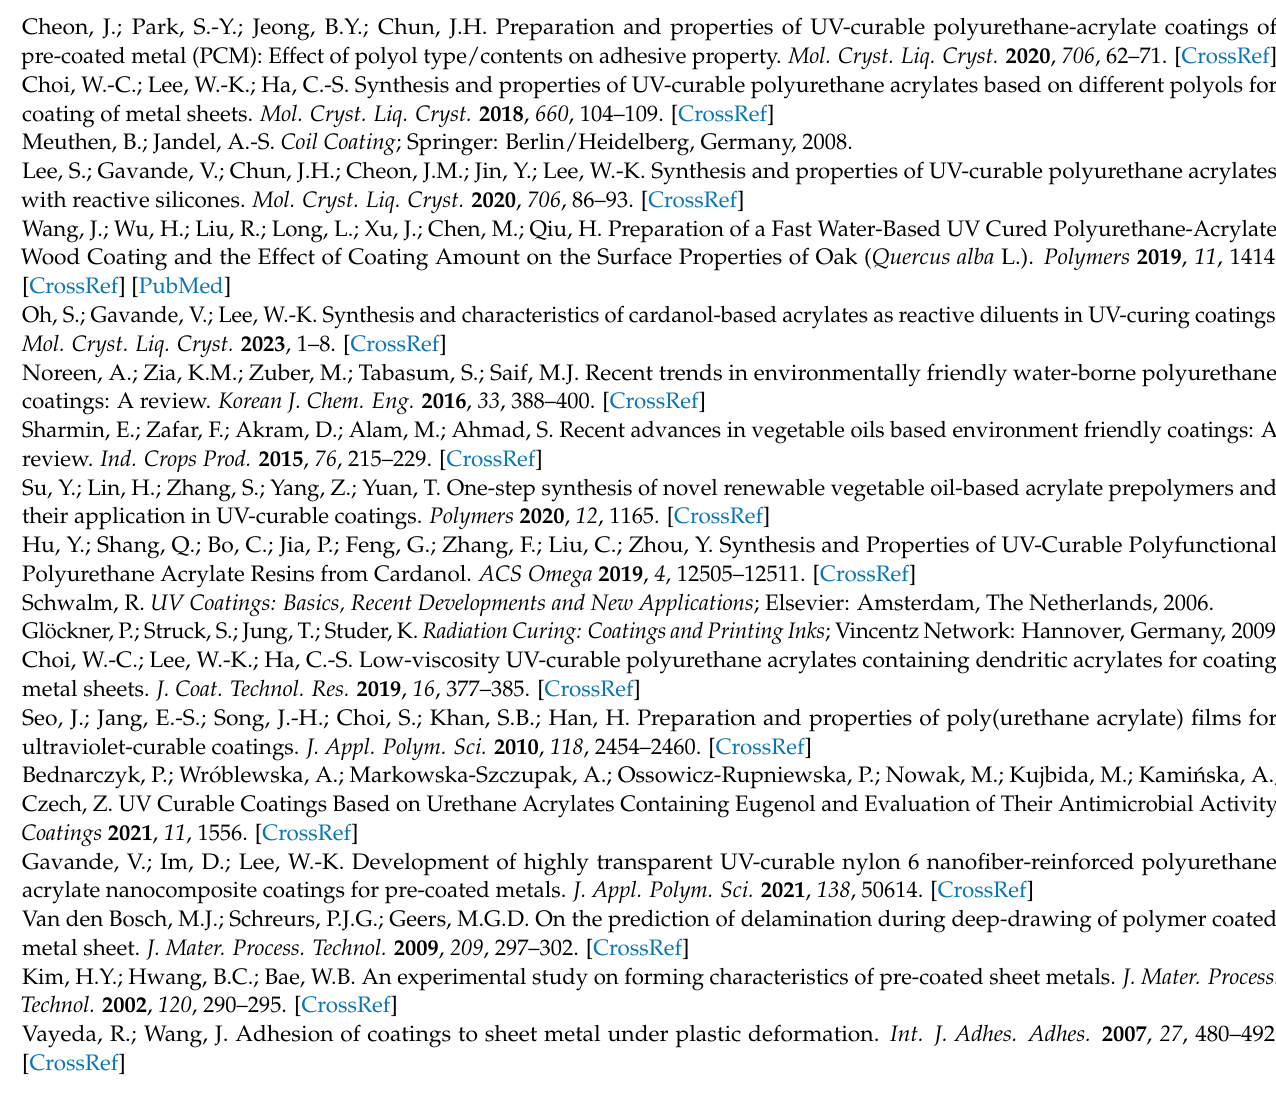
thickness test on UV-cured PUA coating films in the N 2 atmosphere. Figure S9: Formability test: Compression and tension area images of UV-cured PUA coating films in the N 2 atmosphere, and Figure S10: ASAME strain signatures of UV-cured PUA coating films (A) P-IBOA and (B) P-IBOMA in the N 2 atmosphere; Table S1: Viscosities of the UV-curable PUA coatings, Table S2: Gel content (wt%) of the UV-cured PUA coating films, and Table S3: LPH and reduction thickness by Cross-die cup drawing in N2